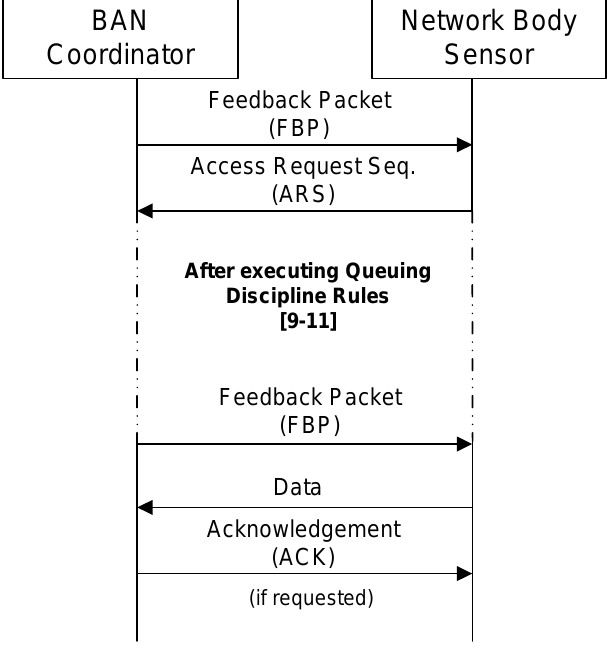
Figure 5. Communication between a body sensor and the BAN